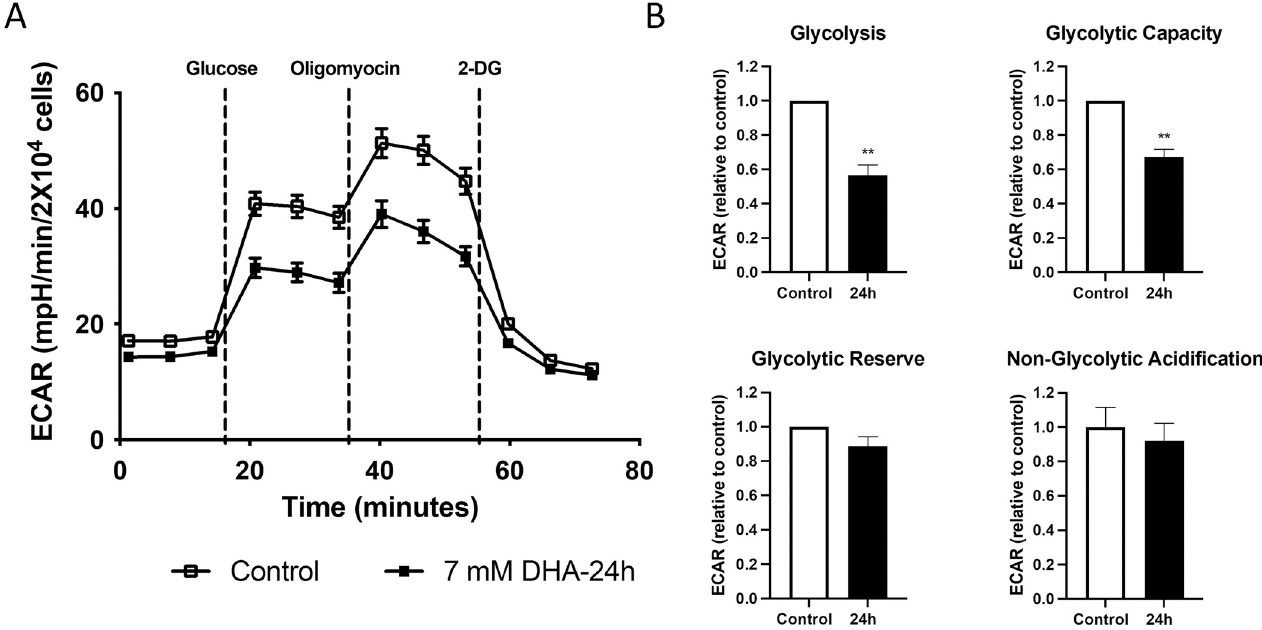
Fig 6. Glycolysis is modulated after DHA exposure. (A) Extracellular acidification rate (ECAR) displayed a shift in cells dosed with 7 mM DHA for 24 h. (B) All measured parameters showed a decrease with a significant difference in the glycolysis and glycolytic capacity. The statistical significance level was marked as �� p <